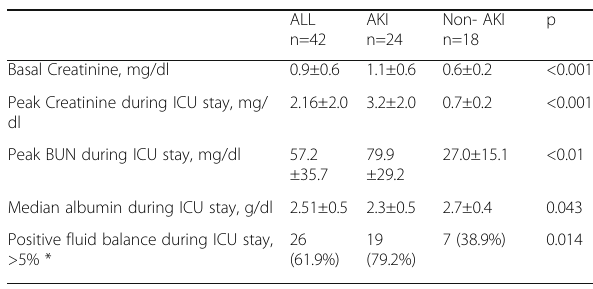
Table 2 (abstract 0410). Comparison of Laboratory variables and fluid balance between AKI and non-AKI